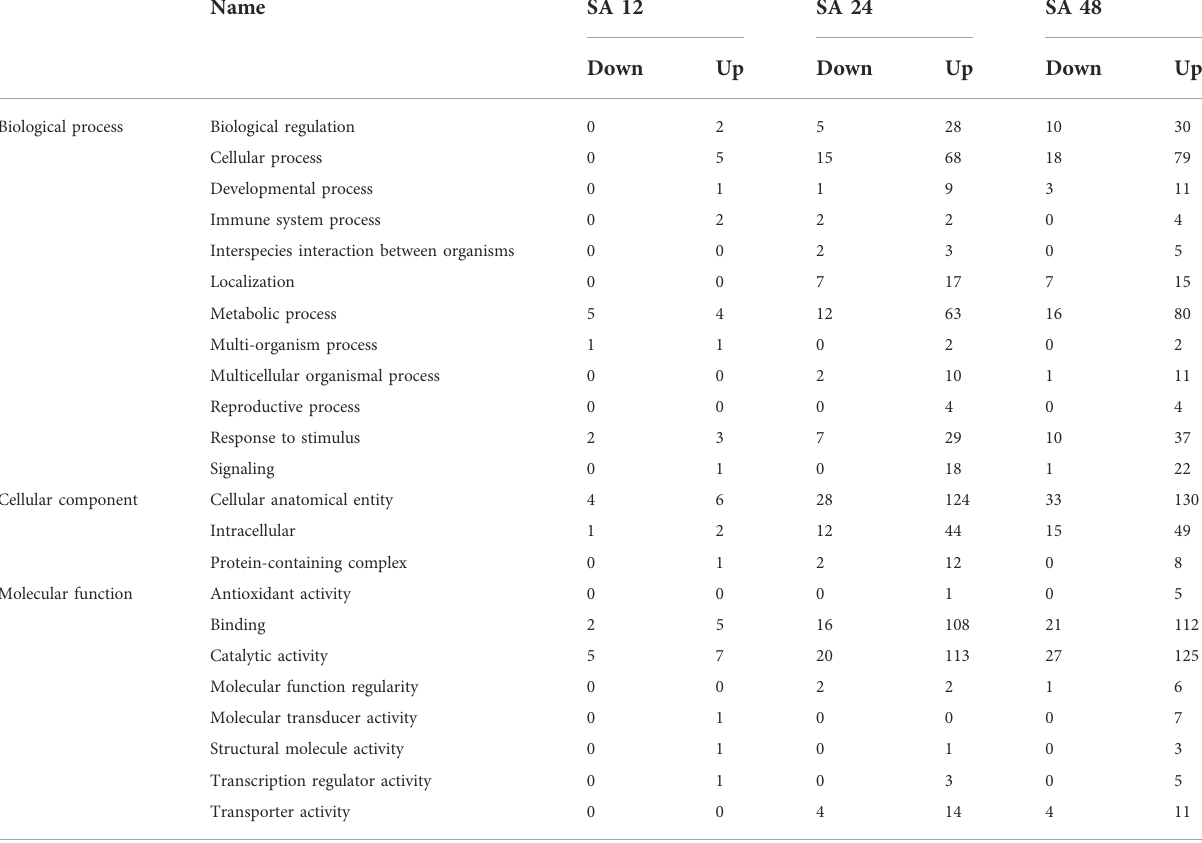
TABLE 3 Functional categorization of DEGs through GO analysis after SA treatment with different time